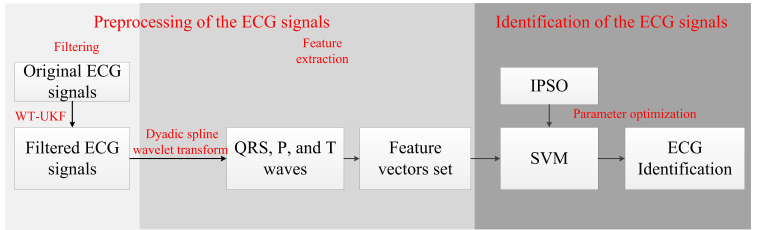
Figure 1. Block diagram of the ECG identification system based on WT-UKF and